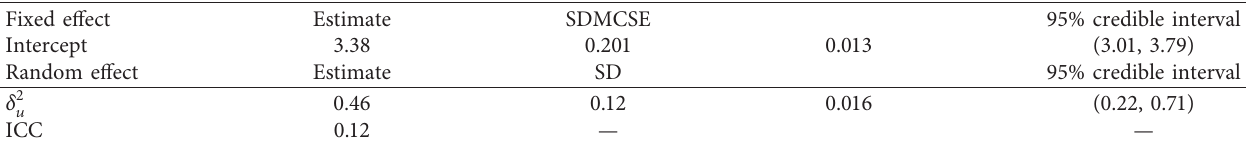
Table 3: Estimates for the variance components model of women’s decision-making nonautonomy on contraceptive utilization, Ethiopia,